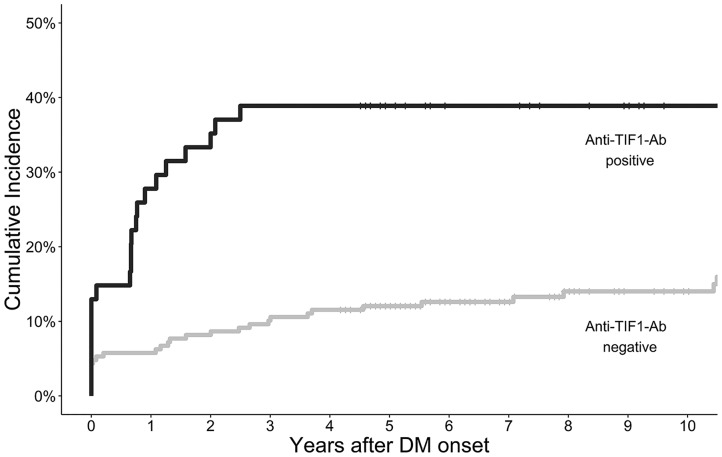
Kaplan-Meier plot of cumulative incidence of cancer onset following dermatomyositis diagnosis stratified according to anti-TIF1-Ab statusAnti-TIF1-Ab: anti-transcriptional intermediary factor 1 antibody.